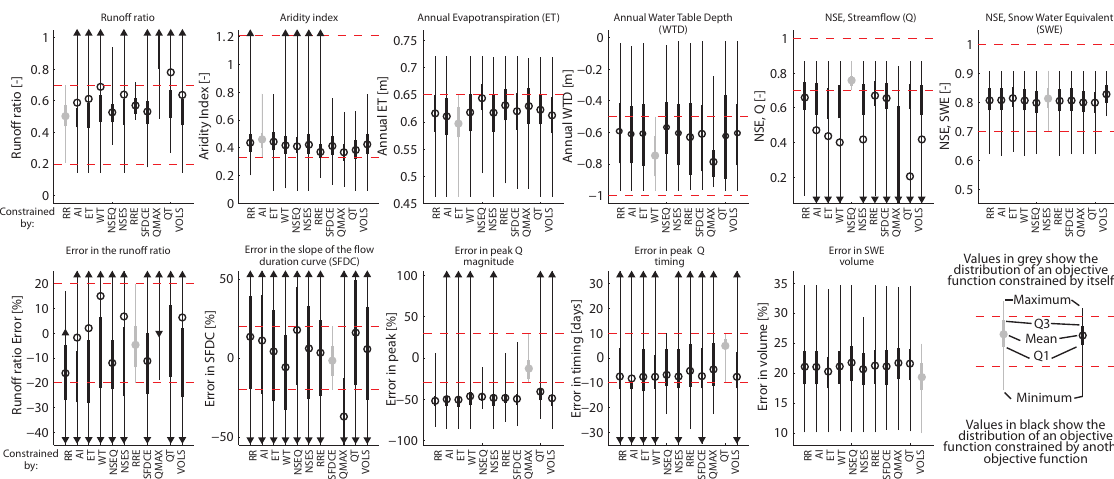
Figure 3. Ranges, interquartile ranges, and mean values for distributions of regional and local signatures, statistical metrics, and dynamic metrics used in the proposed framework. Distributions are shown when a given metric is constrained to behavioral ranges and when a metric is constrained by other metrics, compared to behavioral ranges set in this study. Arrows indicate that ranges exceed the visualized axis limits.